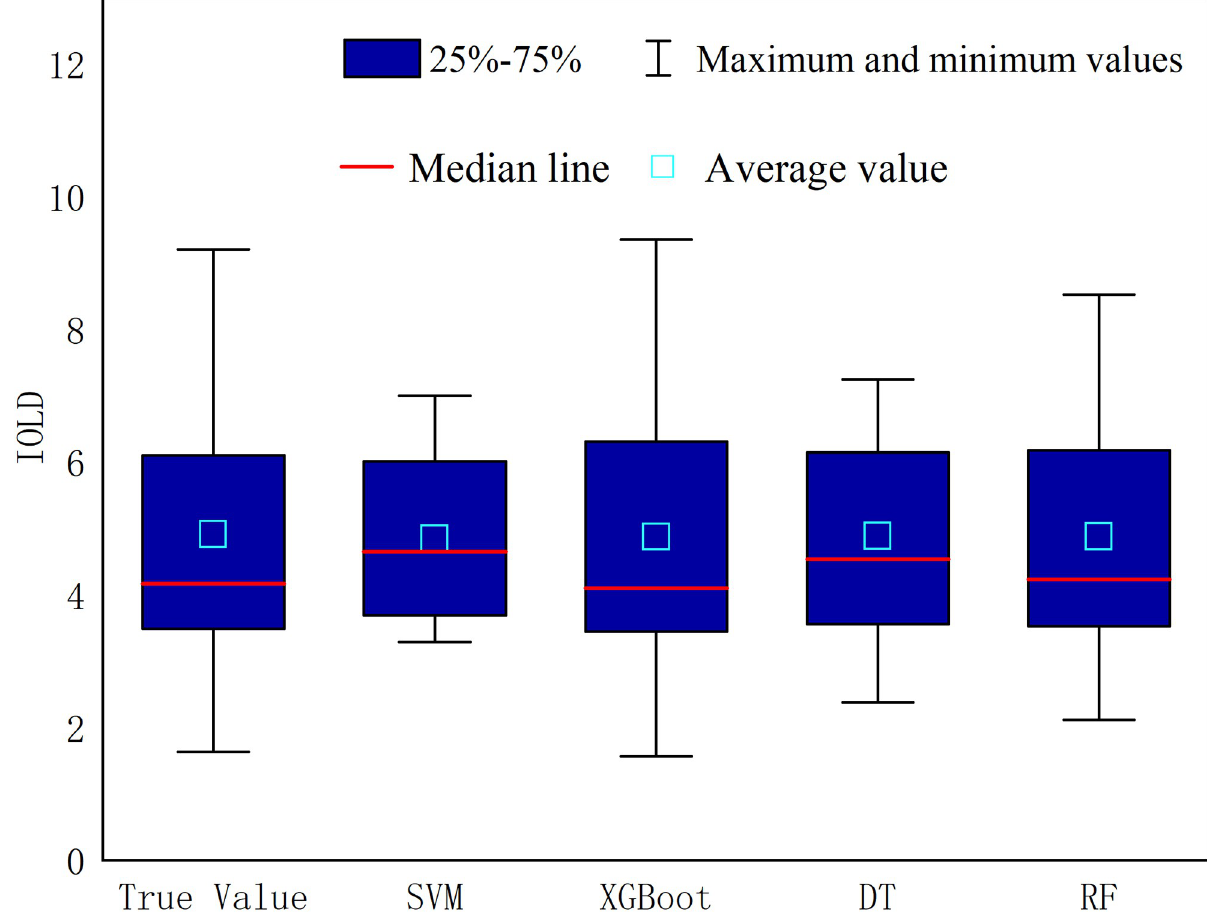
Fig 4. Comparison between the predicted real value and predicted value of the